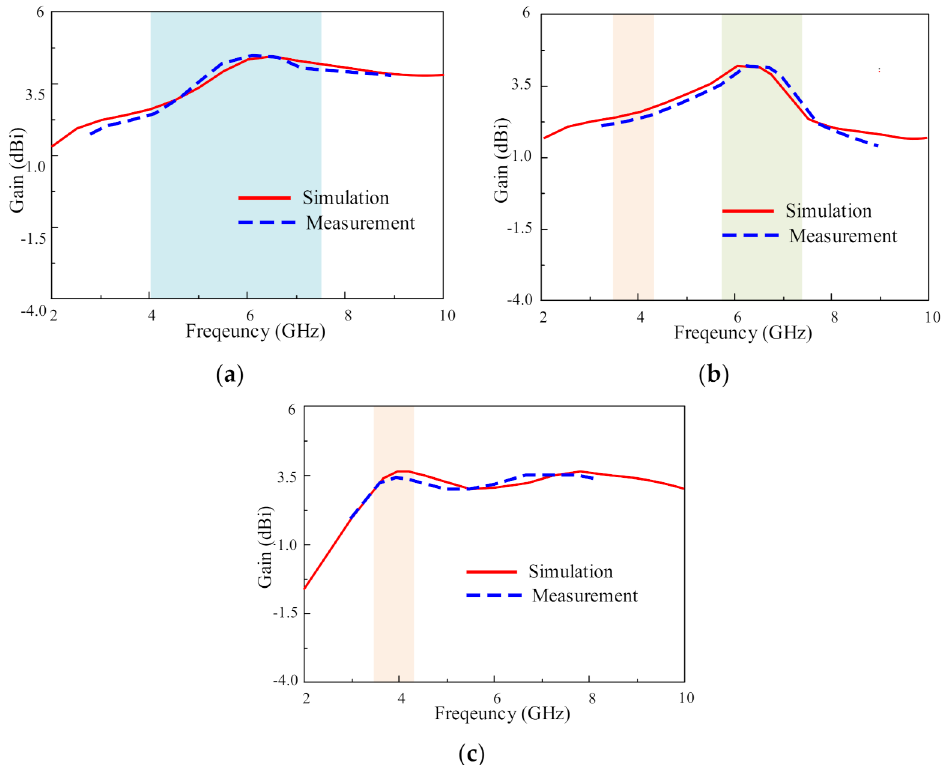
Figure 9. Gain of the proposed antenna for different operating modes: ( a ) wide-band, ( b ) dual-band, and ( c ) single-band.